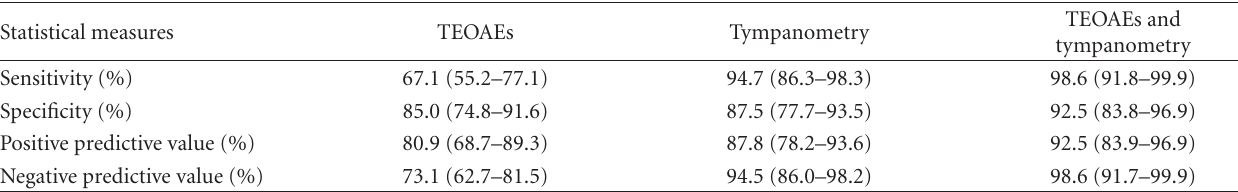
Table 2: Estimates for the sensitivity, specificity, positive predictive value, and negative predictive value of transiently evoked otoacoustic emissions (TEOAEs), tympanometry, and the combined use of both tests. Numbers in parentheses provide estimates of the 95% confidence